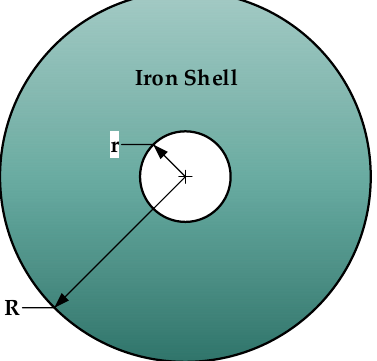
Figure 6. Simpli fi ed ippe_fe geometry of shells 1 to 5 used in one-dimensional S N calculation. Figure 6. Simplified ippe_fe geometry of shells 1 to 5 used in one-dimensional S N